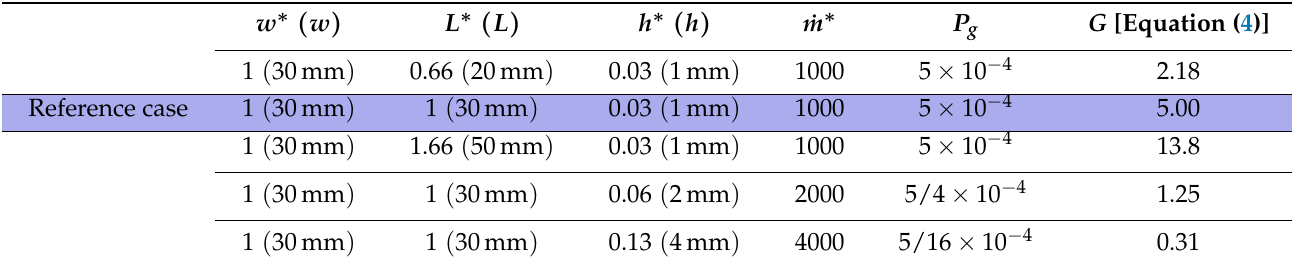
Table 1. Secondary chamber dimensions and parameters for Monte Carlo simulations (and corresponding experimental dimensions). The shaded, second row reports the reference case dimensions and parameters. The top rows show the dimensions and parameters for chambers of different length L ∗ , (first row) with L ∗ = 0.66 in the first row and (third row) L ∗ = 1.66 in the third row. The bottom rows show the dimensions and parameters for chambers with increasing heights h ∗ , with h ∗ = 0.06 in the penultimate row and h ∗ = 0.13 in the last